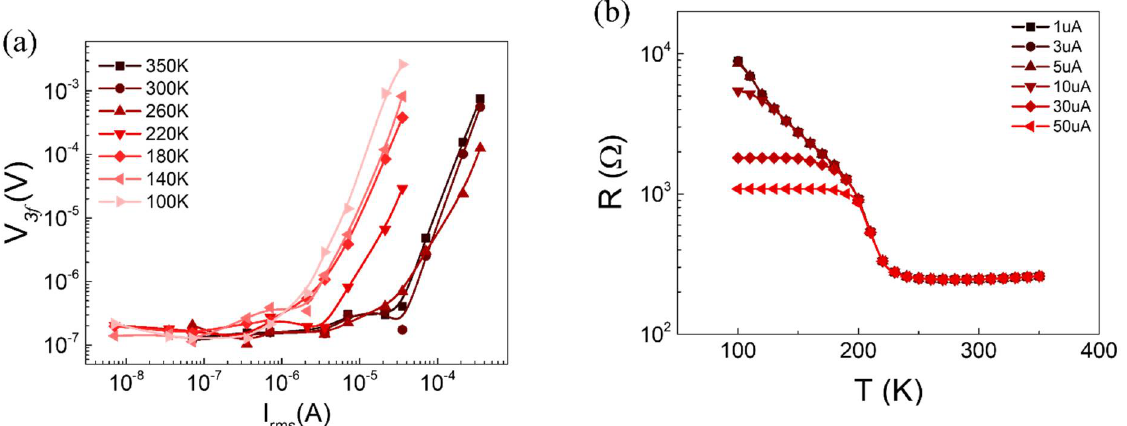
Figure 3. ( a ) V 3f - I rms curves as a function of temperature. ( b ) Resistance–temperature curves as a function of input current I rms .